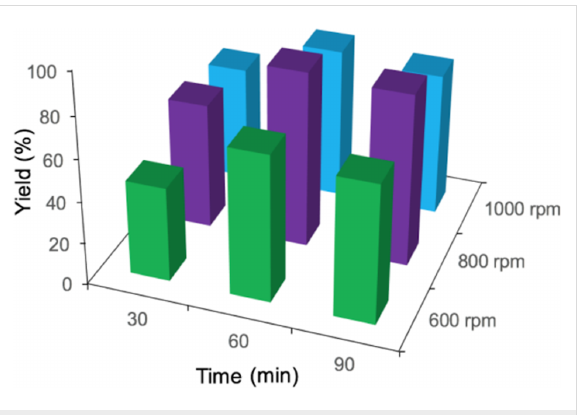
Figure 3: Examination of ball-milling time and rotation speed on the yield of 3aa . Reaction conditions: 1a (1.5 mmol), 2a (2.1 mmol), Pd/ MgAl-LDHs (2.5 mol %), TBAB (1.5 mmol), K 2 CO 3 (3.6 mmol), and 5 g silica gel were placed in a 80 mL stainless-steel vessel ( Φ MB = 0.25, d MB = 5 mm). HSBM conditions: 60 min at 800